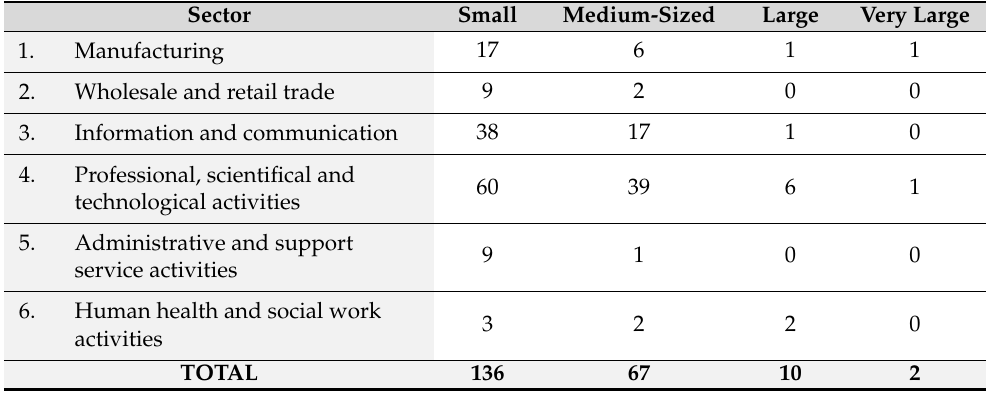
Table 5. Overview of spin-offs by sector and company